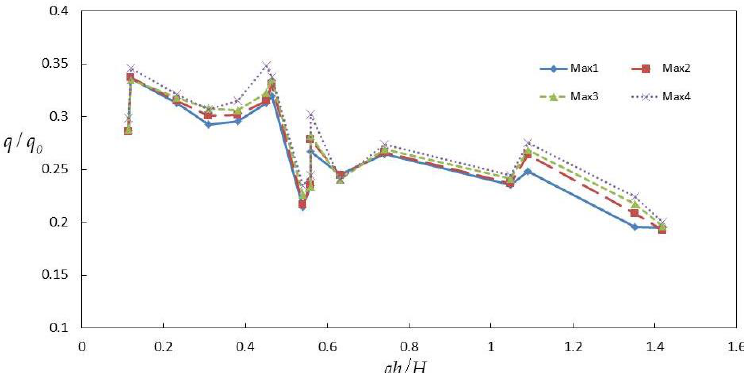
Figure 12. Ratio of single-width-discharges q/q 0 varies with the comprehensive parameter ah/H . (calculated from original velocity data with different velocity integration in experiments of Dunn et al. [1]).